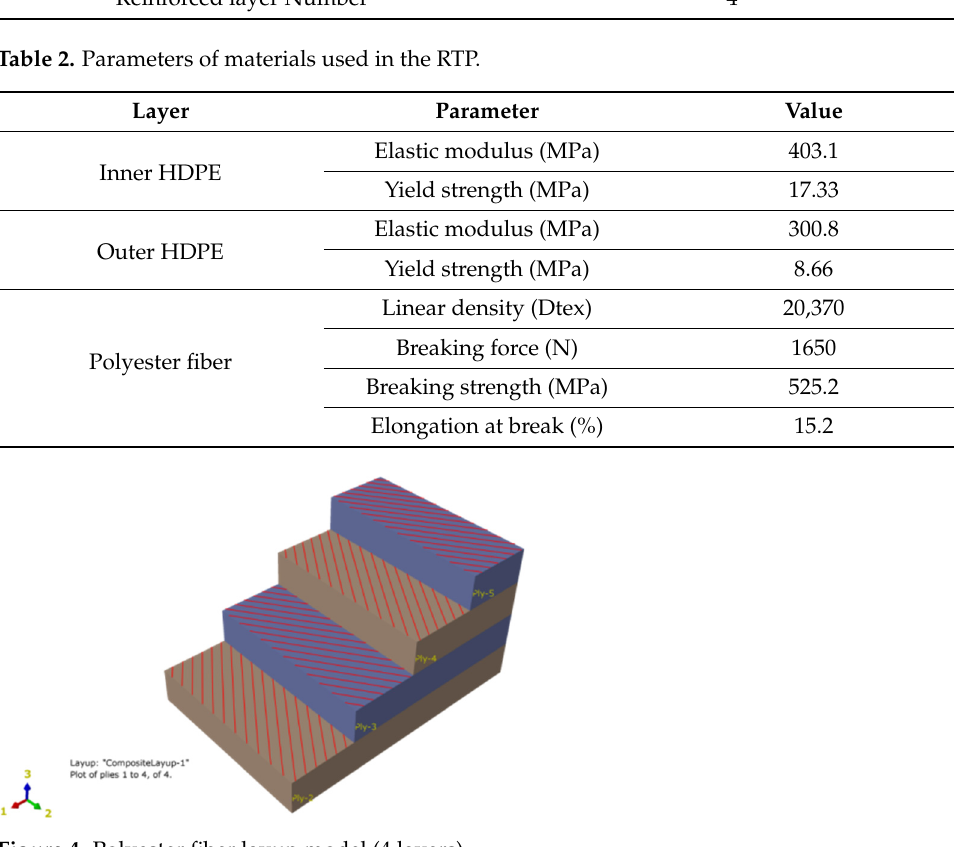
Figure 4. Polyester fiber layup model (4 layers).